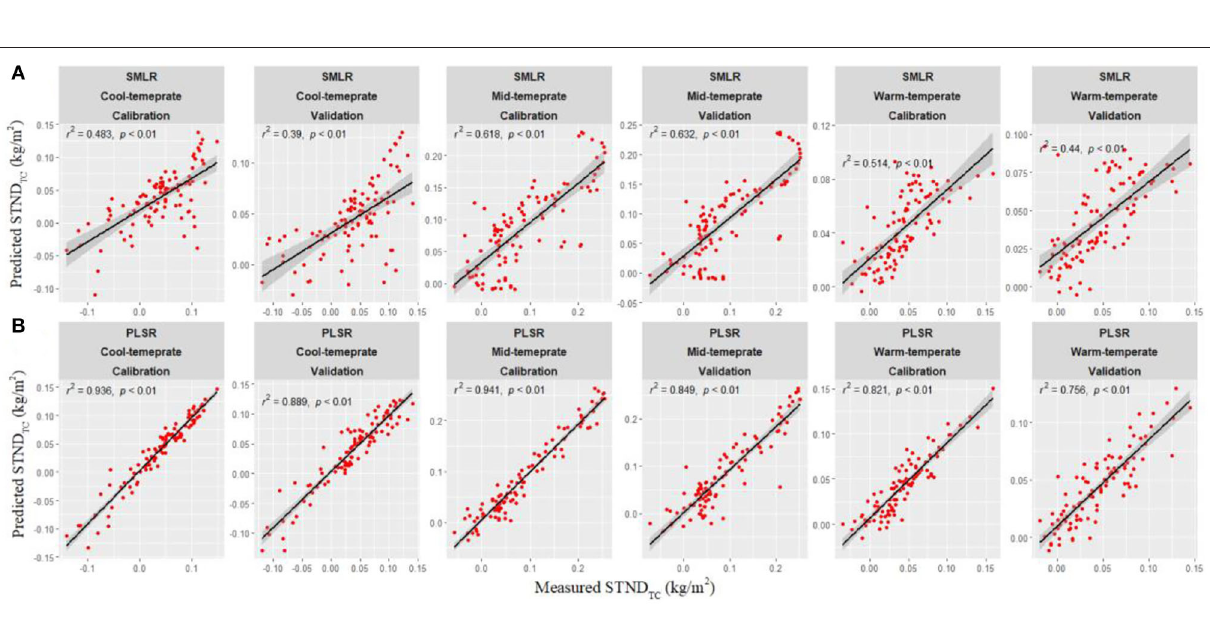
FIGURE 6 | Scatterplots between the measured and predicted temporal change of soil nitrogen density (SND T ) by (A) the stepwise multiple linear regression (SMLR) from the influencing factors and (B) the partial least squares regression